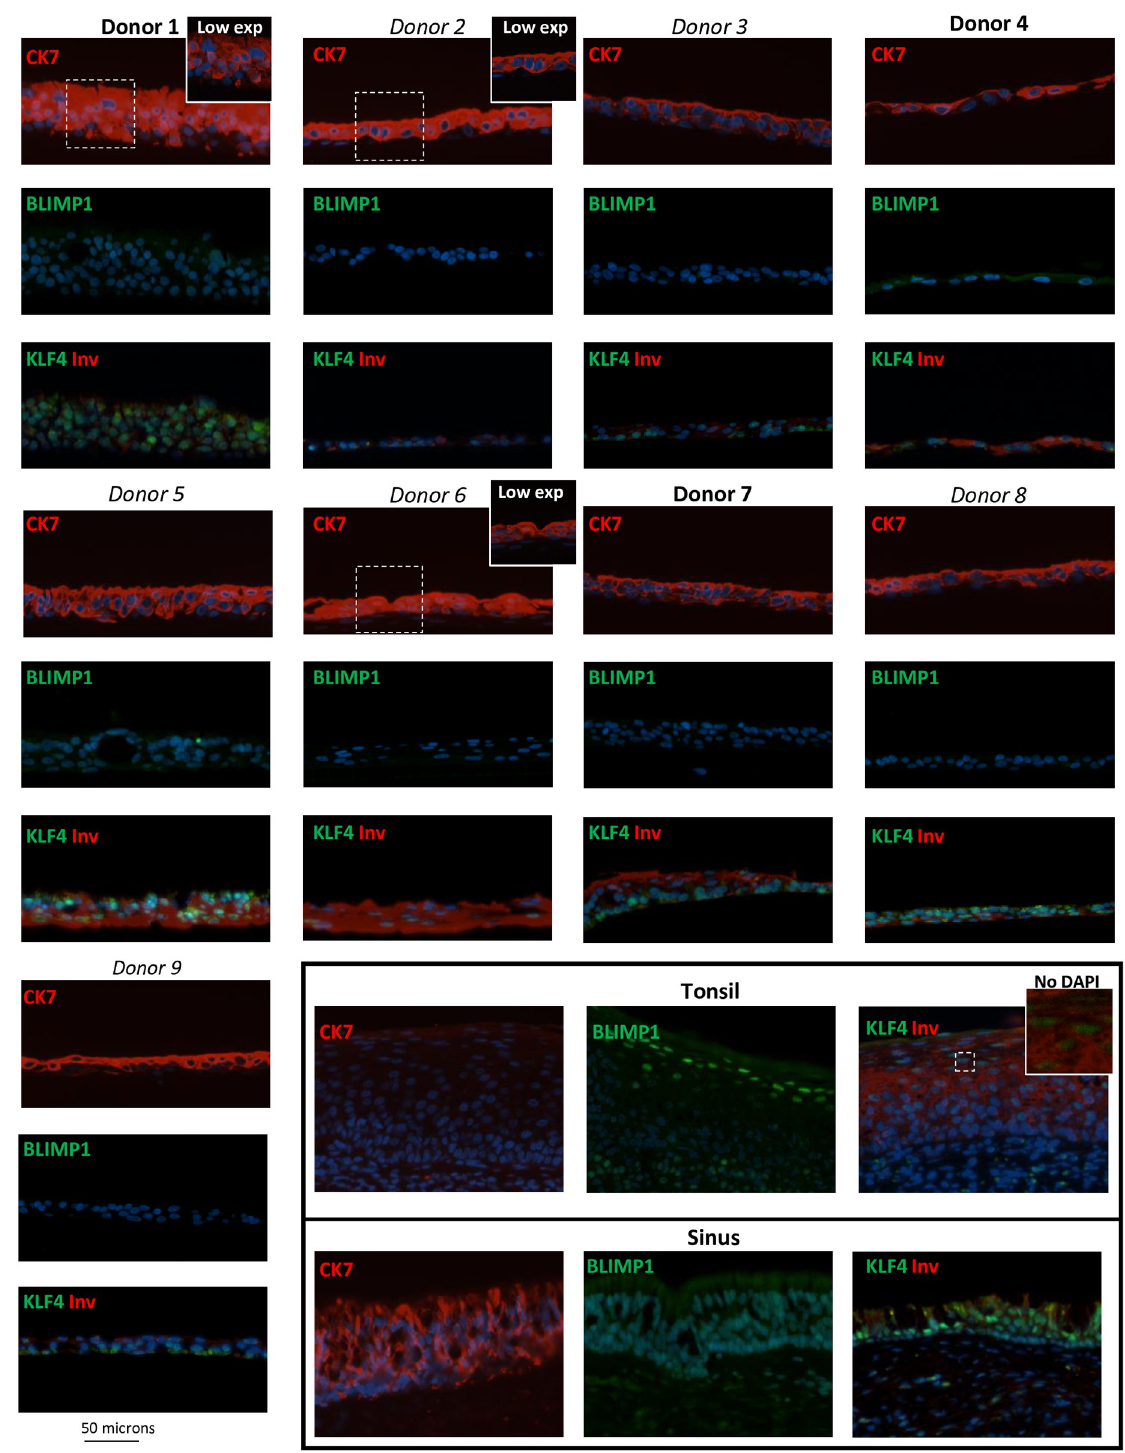
Fig 3. Immunostaining for markers of the pseudostratified epithelium and cellular differentiation factors. Immunofluorescence images of FFPE sections from pseudo-ALI cultures stained for the pseudostratified epithelial marker (CK7) and markers of cellular differentiation (BLIMP1, KLF4 and Inv). Sinus and tonsil sections served as control tissue for the pseudostratified and squamous epithelium, respectively. CK7, cytokeratin 7; Inv, involucrin; Low exp, low exposure.